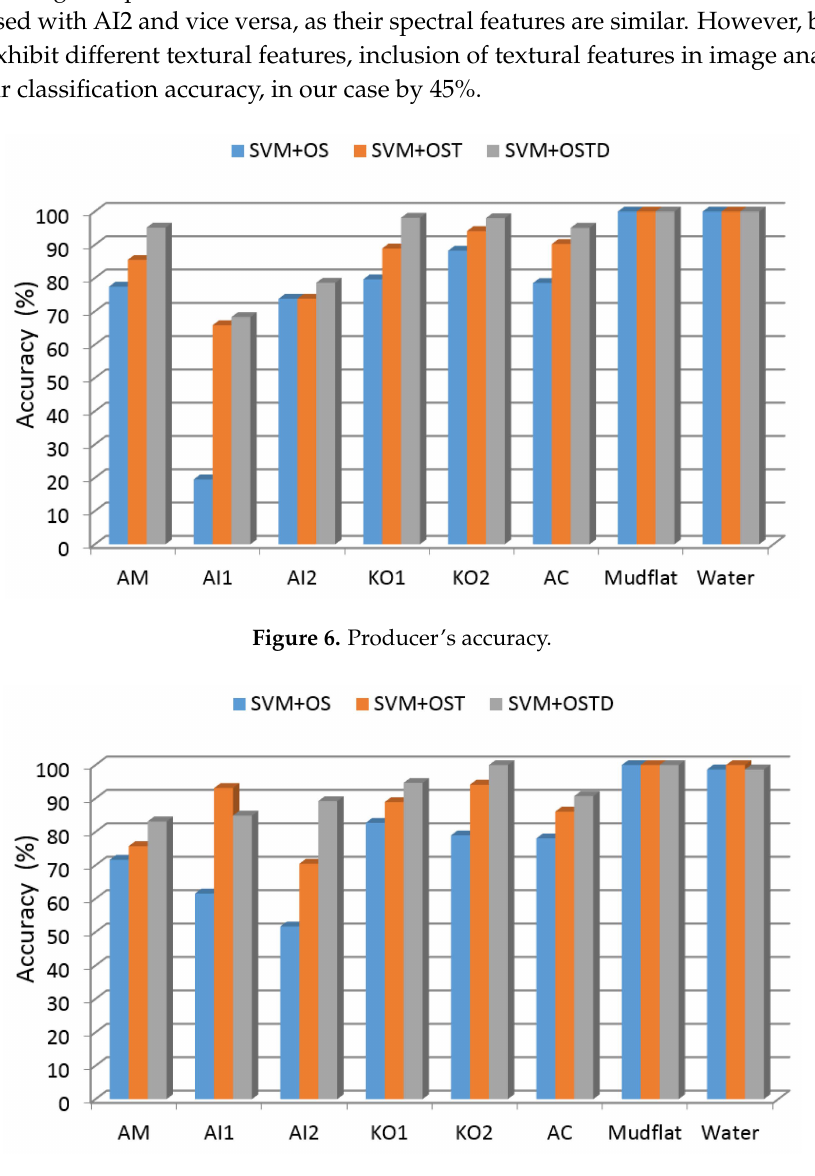
Figure 7. User’s